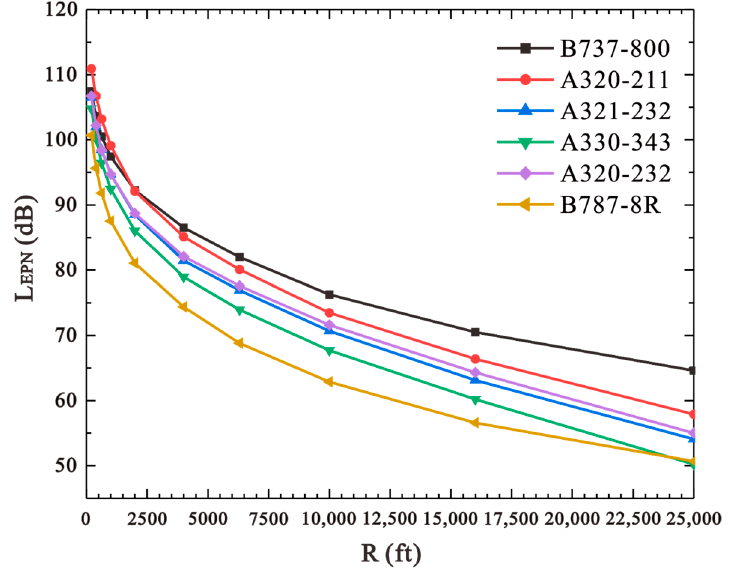
Figure 2. NPD curve of the main aircraft types at BIA (thrust = 19,000 lb). Table 1. Information on the main aircraft types at BIA [30].